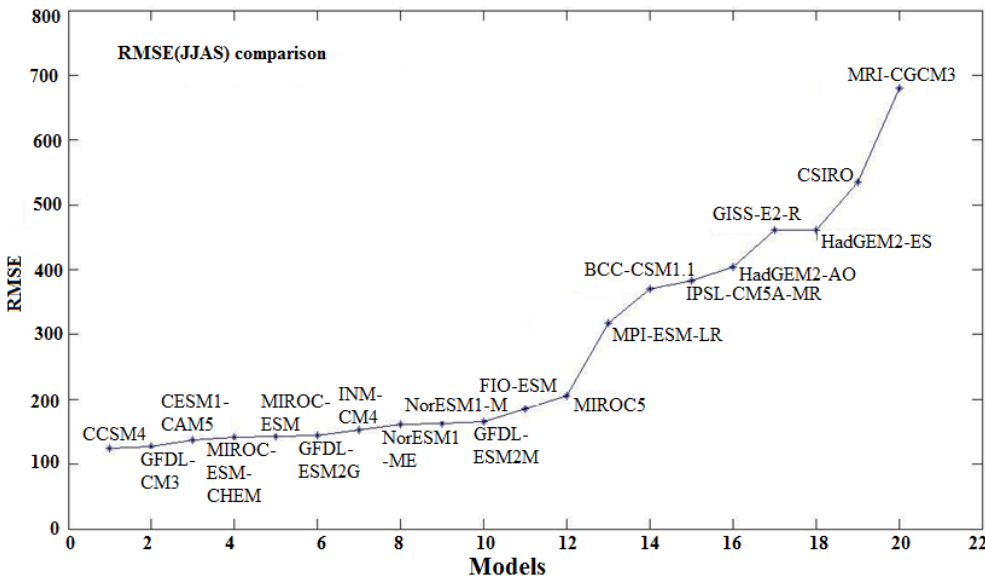
Figure 5. Root means square error between AISMR observed and models during